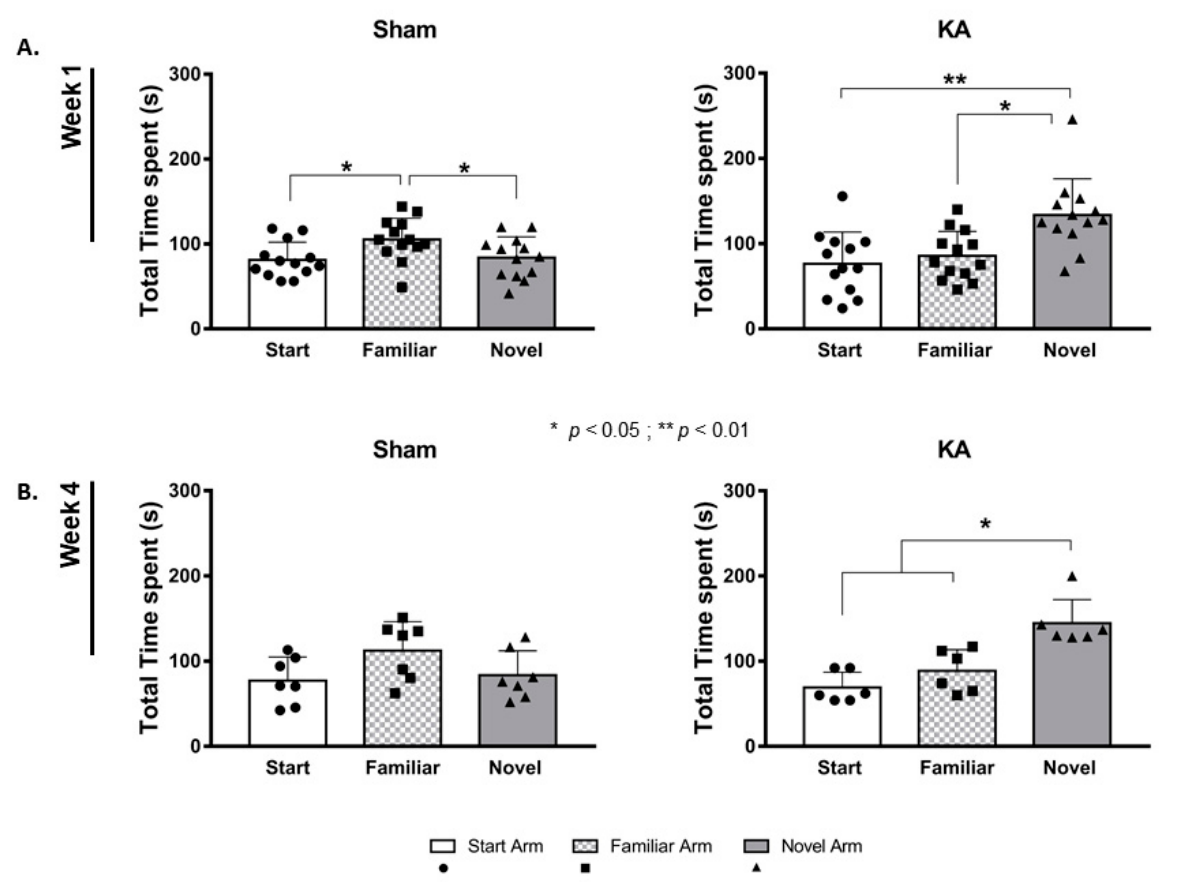
Figure 6. Enhanced exploratory behavior at weeks 1 and 4 following continuous micro-perfusion of Kainic Acid into the AN. Graph representing the mean ± SEM of the total time spent in the novel, familiar (second arm), and start arms. The test was performed at week 1 ( A ) and at week 4 ( B ) following the saline ( n = 7 and n = 13 for week 1 and week 4, respectively) or KA micro-perfusion ( n = 6 and n = 13 for week 1 and week 4, respectively). One-way repeated measures ANOVA followed by Tukey’s multiple comparison test was performed to determine statistically significant differences in the total time spent between the different arms within the same group.